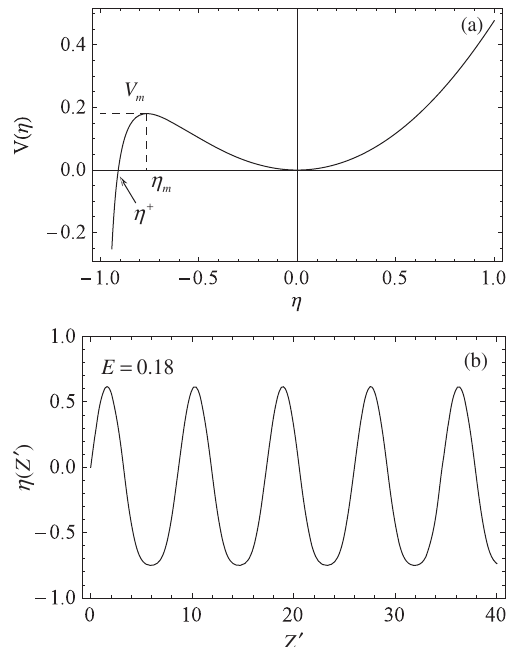
FIG. 17. Plots are shown for (a) V ð η Þ versus η , and (b) η ð Z 0 Þ versus Z 0 , obtained from Eq. (94) for M 2 ¼ 0 . 09 , η 0 ð 0 Þ ¼ 0 . 6 , E ¼ ð 1 = 2 Þ½ η 0 ð 0 Þ(cid:4) 2 ¼ 0 . 18 , η þ ¼ − 0 . 91 , η 0 . 181 . V ð η m Þ ¼